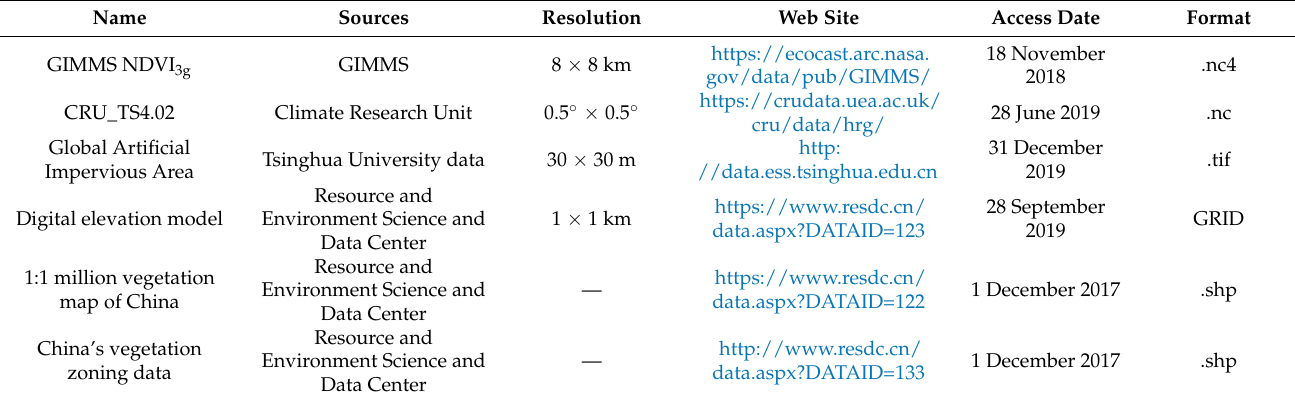
Table 1. The source of primary data and related